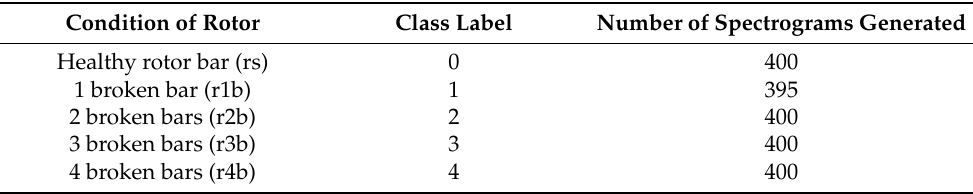
Table 1. Number of spectrogram samples generated for each label. Condition of